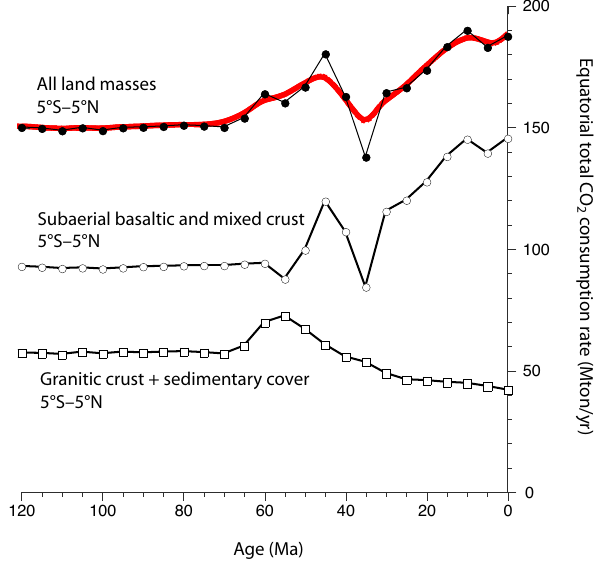
Fig. 7. Total CO 2 consumption rates from silicate weathering since 120Ma of land areas in equatorial humid belt (5 ◦ S–5 ◦ N) obtained by multiplying a nominal CO 2 consumption rate of 100tCO 2 yr − 1 km − 2 for basaltic provinces and 50tyr − 1 km − 2 for mixed basaltic-metamorphic provinces (Dessert et al., 2003) and an order of magnitude less (5tyr − 1 km − 2 ) for the remaining continen- tal land areas (Gaillardet et al., 1999) to the corresponding cumula- tive distribution curves in Fig. 6. Note that these total consumption rates should be divided by 2 for net CO 2 consumption rates be- cause half of the CO 2 consumed by silicate weathering is returned to the atmosphere–ocean during carbonate precipitation. For exam- ple, total CO 2 consumption of 190MtCO 2 yr − 1 would correspond to a net CO 2 consumption of 190/2=95MtCO 2 yr − 1 , or ∼ 35% of present-day global volcanic CO 2 outgassing of 260MtCO 2 yr − 1 . For reference, the consumption of 1MtCO 2 yr − 1 can be sus- tained by introducing into the equatorial humid belt or rejuvenating roughly 10000km 2 (or ∼ 20000km 2 for net) of the SE Asia arc terrane every million